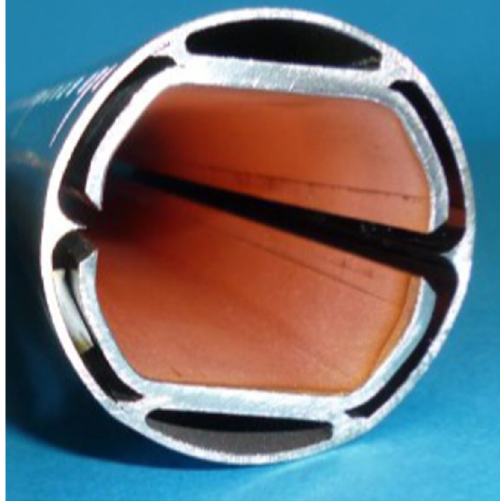
FIG. 7. Cross section of the proposed FCC-hh vacuum chamber [22].